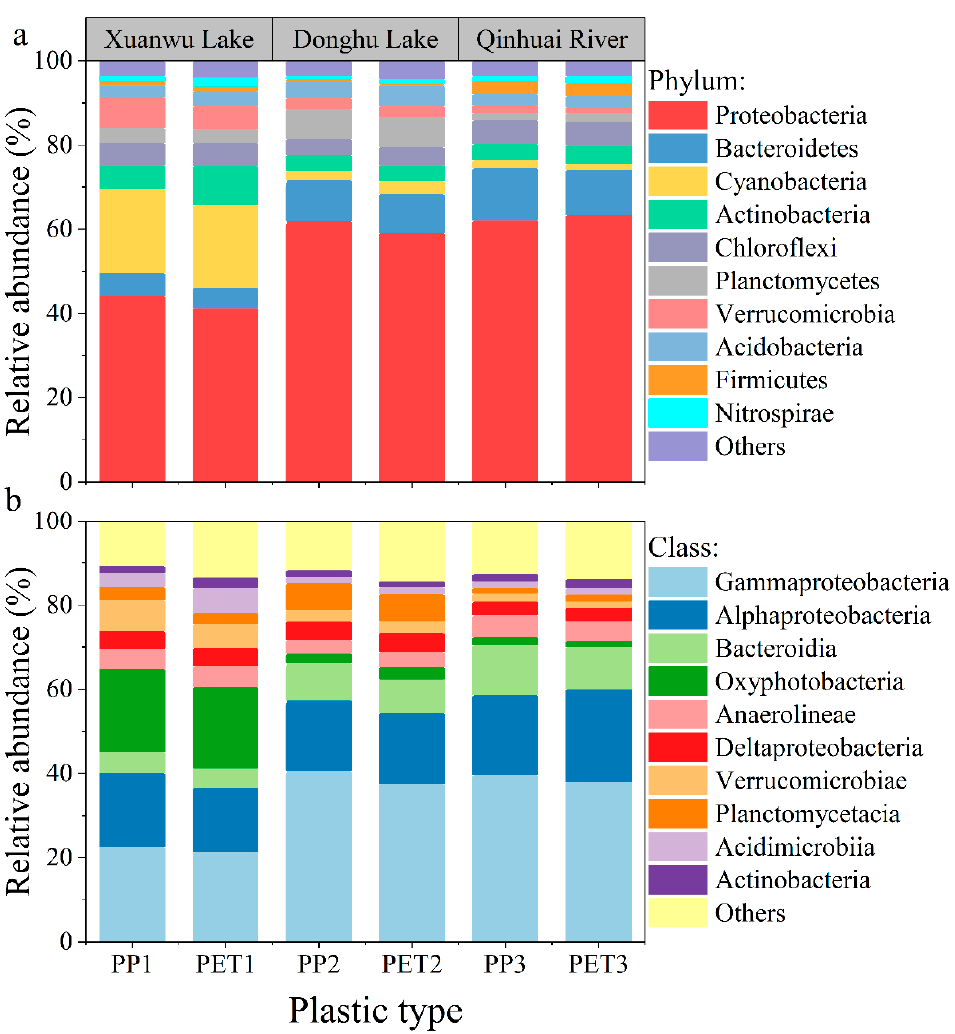
Figure 2. The abundance of bacteria at the phylum level ( a ) and class level ( b ) in biofilms on plastic debris. PP1 and PET1: biofilm-covered plastic in Xuanwu Lake; PP2 and PET2: biofilm-covered plastic in Donghu Lake; and PP3 and PET3: biofilm-covered plastic in the Qinhuai River.